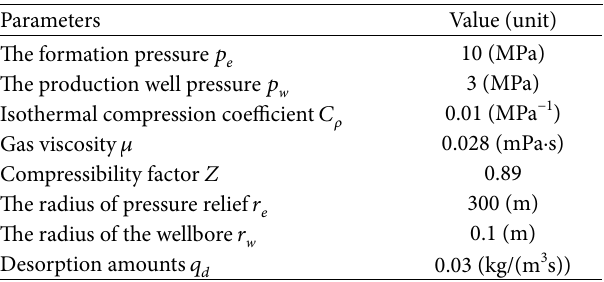
Table 4: The basic parameters of the target block.